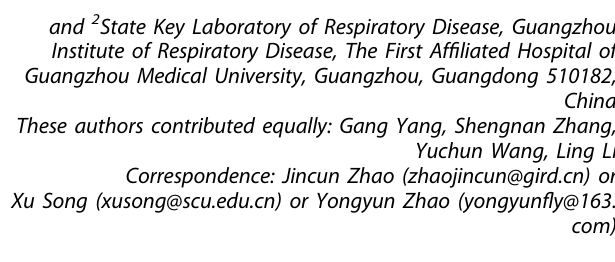
Fig. 1 Aptamers selectively inhibit SARS-CoV-2 induced in fl ammation. a The secondary structure of the aptamer ST-6 (orange), ST-6-1 (green) and ST-6-2 (purple) were predicted using RNAfold by adjusting the DNA and G-quadruplex parameter. b BLI assay for the kinetic binding parameters of aptamer binding to immobilized spike proteins. c Flow cytometry to investigate the binding performance of cy3-labeled aptamer (200 nM) to spike protein (2 μ g) pre-bind to Ni-beads (3 μ L). Random sequences (RS) were used as baseline controls. d ELISA reveals the ef fi ciency of aptamers in prevention experiments. Aptamer (200 nM) was incubated with spike protein (100 ng/well) pre-coated on a microplate before the addition of TLR4 (200 ng/well). e , f qRT-PCR analysis for the expression of cytokine in cells treated with 10 nM SARS- Spike-Tri or RBD of spike protein, 10 nM SARS-Spike-Tri + 200 nM aptamer, 10 nM SARS-Spike-Tri + 100 μ M Resatorvid for 2 h. SARS-Spike-Tri is short for the spike protein trimer of SARS-CoV2. RS: Random sequences. g The inhibition ef fi ciency of aptamer on IL-1B production in THP-1 cells stimulated with spike protein from SARS-CoV-2 variants (the Delta, Lambda and Omicron variants). THP-1 cells were treated with 10 nM SARS-Spike-Tri-variant, 10 nM SARS-Spike-Tri- variant + 200 nM aptamer, 10 nM SARS-Spike-Tri- variant + 100 μ M Resatorvid for 2 h. SARS- Spike-Tri-variant is short for the spike protein trimer of SARS-CoV2 variants. RS: Random sequences. h qRT-PCR analysis for the cytokine inhibition in THP-1 cells infected with 2 × 10 6 PFU/mL authentic SARS-CoV-2 with different concentrations of aptamers for 2 h. RS: Random sequences. i qRT-PCR analysis of immune response to LPS in cells pretreated with spike-Tri and aptamer. Cells treated with 50 ng/mL LPS, 50 ng/mL LPS + 200 nM aptamer, 50 ng/mL LPS + 100 μ M Resatorvid, 10 nM SARS-Spike-Tri, 10 nM SARS-Spike-Tri + 200 nM aptamer, 10 nM SARS-Spike-Tri + 100 μ M Resatorvid, 10 nM SARS-Spike-Tri + 200 nM aptamer, 10 nM SARS-Spike-Tri + 200 nM aptamer + 50 ng/mL LPS, 10 nM SARS-Spike-Tri + 100 μ M Resatorvid + 50 ng/mL LPS for 2 h. All the error bars indicate standard deviations ( n = 3). All the P values were determined using paired t test. *** P <